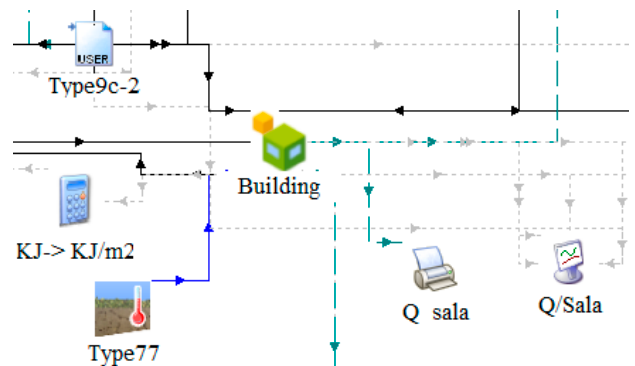
Figure 9. Detail of building block in TRNSYS simulation.